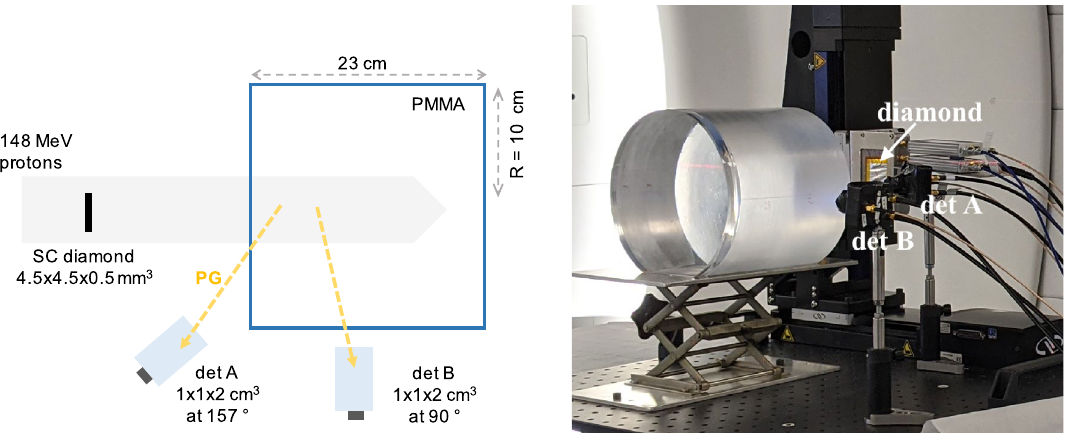
Figure 9. Experimental set-up for the PGT profile measurement at the S2C2 facility. The 23 cm thick, 10 cm radius PMMA target fully stopped the 148 MeV protons after a range of 13.4 cm. Two gamma detector modules were placed upstream the target (det A, at 157 ◦ ) and at the Bragg peak (det B, at 90 ◦ ). Each module was composed of a 2 cm 3 PbF 2 crystal coupled to a 6 6 mm 2 SiPM. The effective beam intensity at the beam × monitor level was 0.78